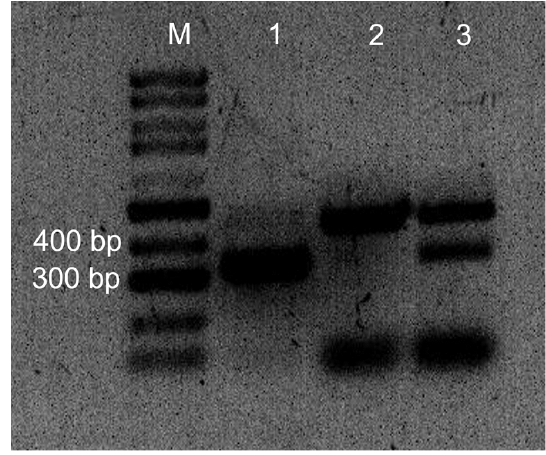
Figure 2 . Gel image of species-specific PCR products of Leptosphaeria maculans ‘brassicae’ and L. biglobosa ‘brassicae’ isolates in inoculated Westar cotyledons. PCR identification of L. biglobosa and L. maculans with species-specific primers, LmacF/LmacR and LbigF/LmacR in a multiplex PCR. L. biglobosa ‘brassicae’ and L. maculans ‘brassicae’ gave PCR bands of 444 bp and 331 bp, respectively. PCR products were resolved by electrophoresis through a 1% ( w / v ) agarose gel. Lane 1: L. maculans ‘brassicae’ inoculated cotyledon gDNA; Lane 2: L. biglobosa ‘brassicae’ inoculated cotyledon gDNA; Lane 3: both isolates co-inoculated cotyledon gDNA; M: 100 bp DNA ladder.